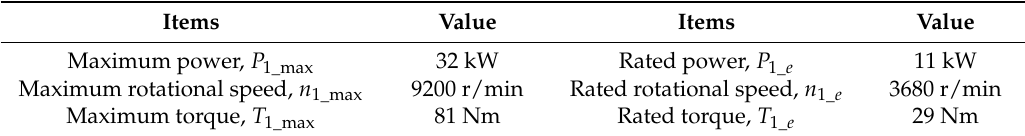
Table 6. Determined parameters of M/G1.